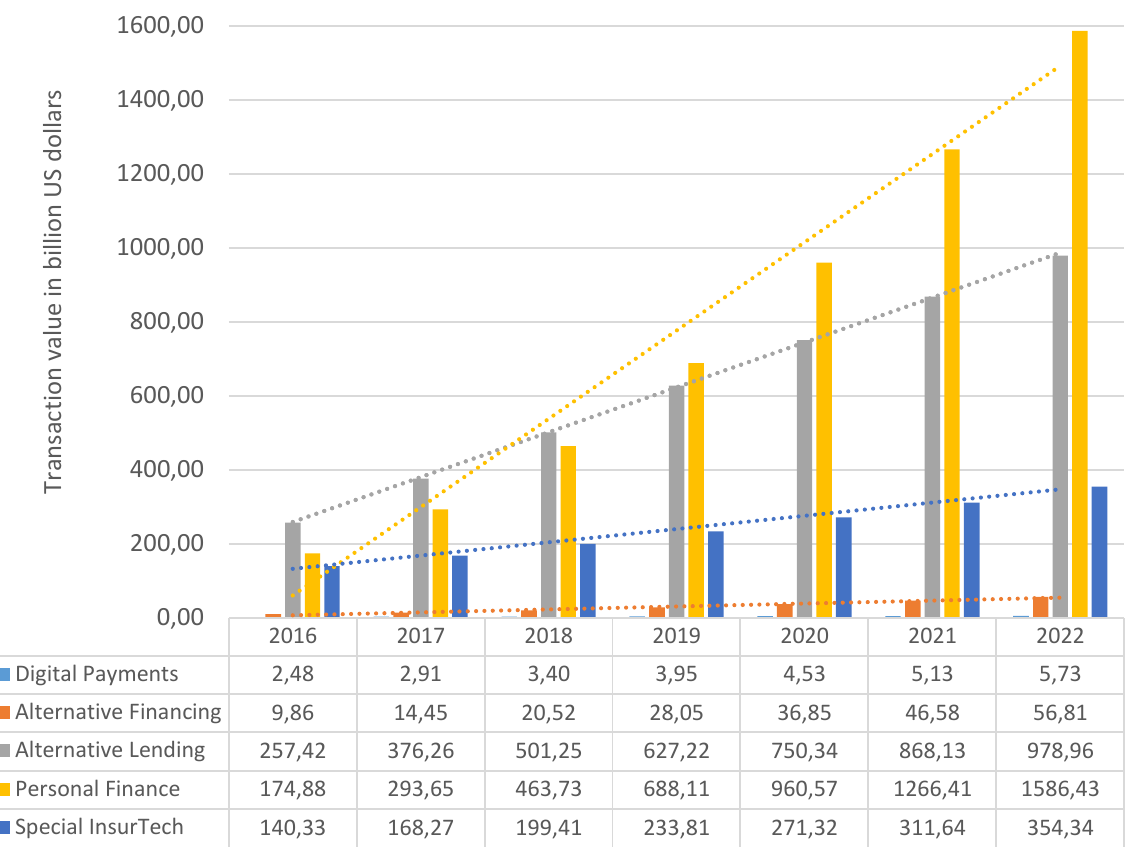
Figure 2. Cost of transactions in the FinTech Industry, billion US